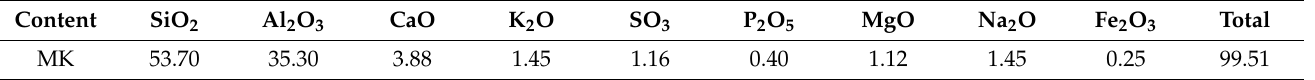
Figure 1. Raw materials and phase composition: ( a ) metakaolin and ( b ) XRD analysis of metakaolin. Table 1. The main chemical compositions (by wt.%) of the